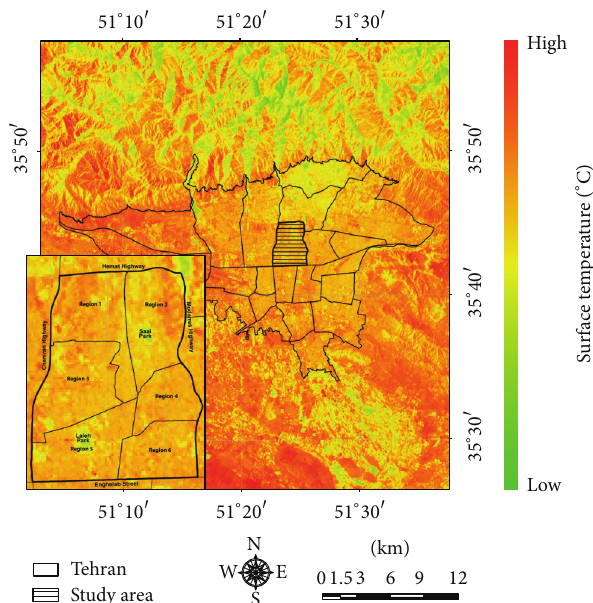
Figure 7: : Land surface temperature from Landsat on July 18th